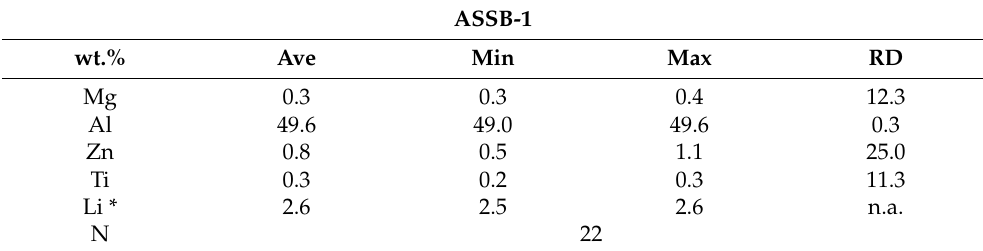
Table A2. Composition of Sp (wt.%) based on single-point analysis (only in ASSB-1). Ave.: arith- metic average; Min./Max.: lowest/highest measured values: RD: relative standard deviation (%); * calculated value; N: number of measurements; n.a. not applicable (calculated values).